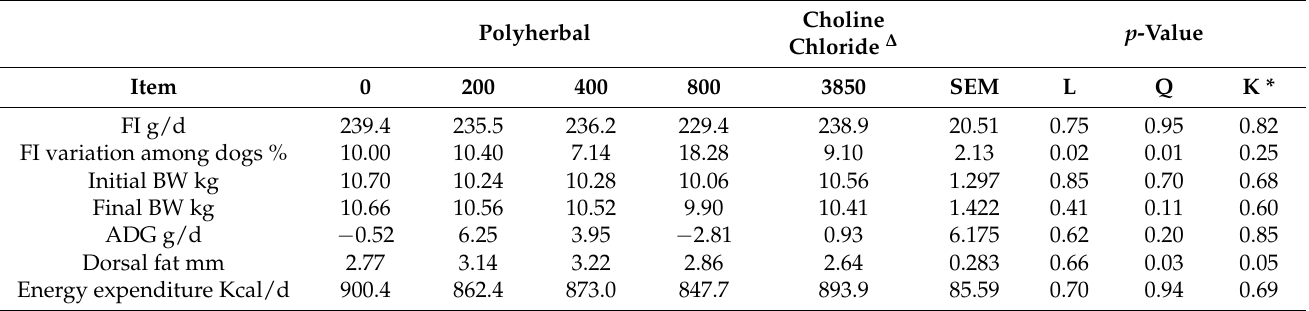
Table 1. Effect of polyherbal level versus choline chloride (mg/kg) on feed intake (FI), body weight (BW) changes, dorsal fat, and energy